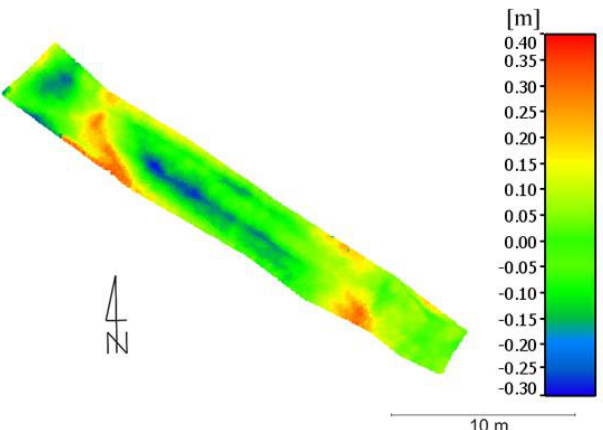
Figure 18. Distribution of differences in the height of the point cloud in relation to the reference model (Test Area No. 2).